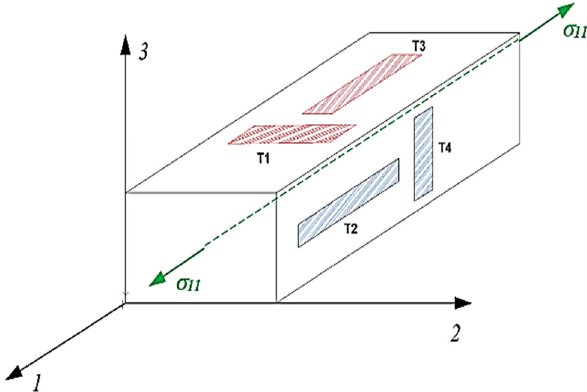
Figure 10: Arrangement of strain gauges on the sample measuring surfaces.